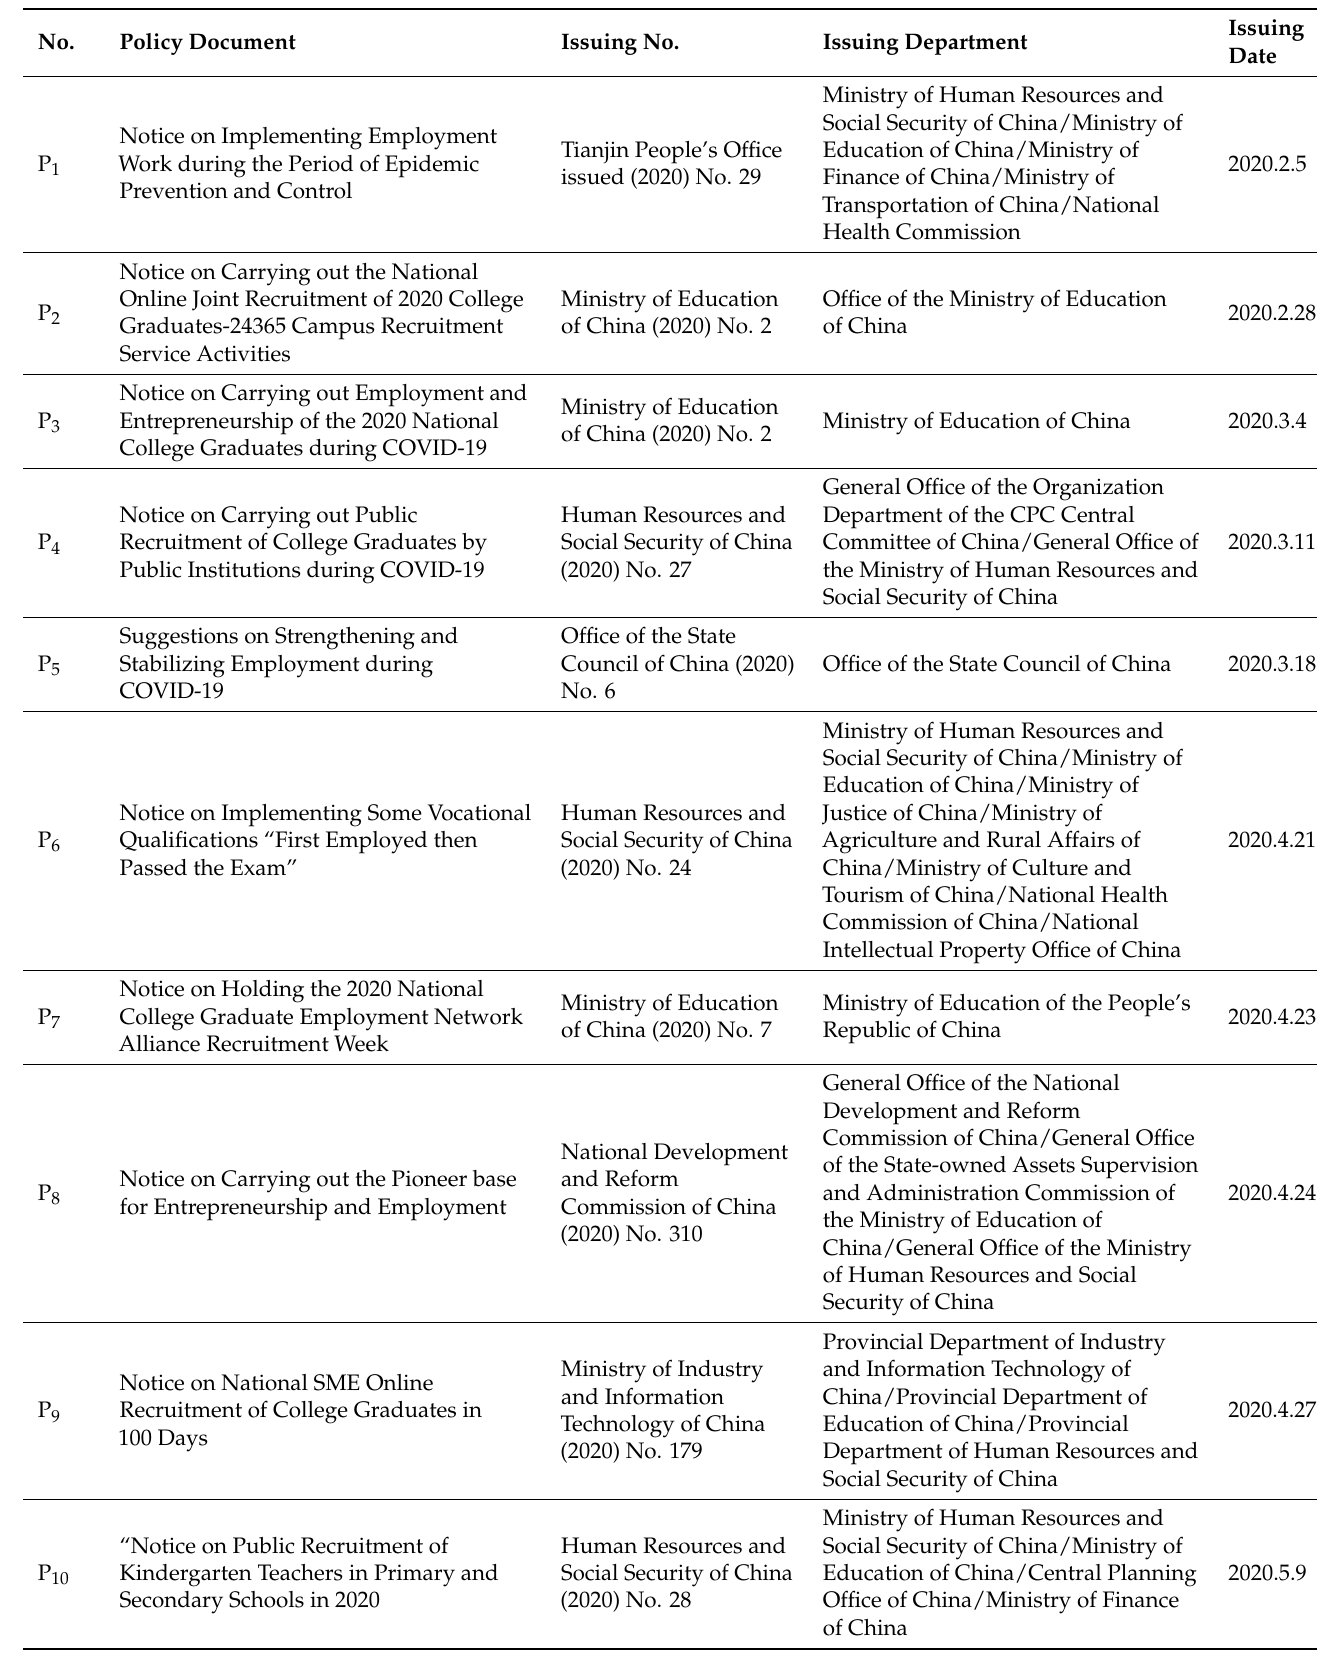
Table 1. Documents of employment promotion policy for college